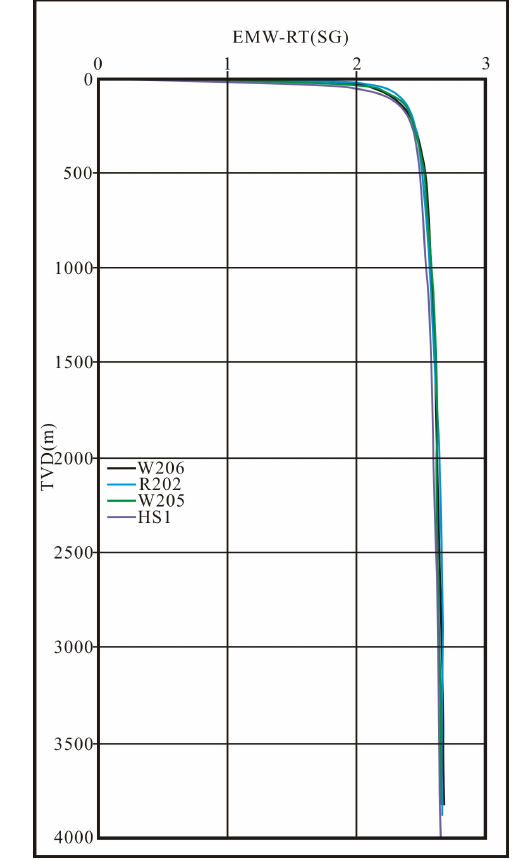
Figure 3. Overburden gradient in several wells.